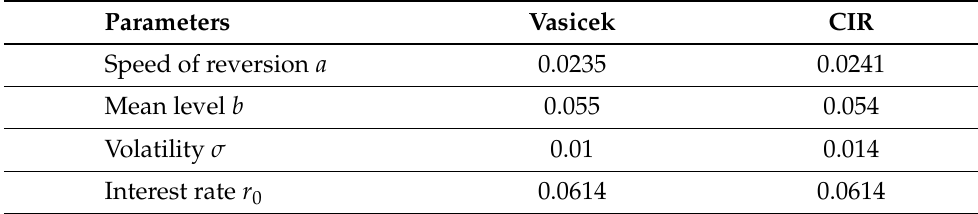
Table 6. Parameters considered in the Vasicek and CIR models for cat bond